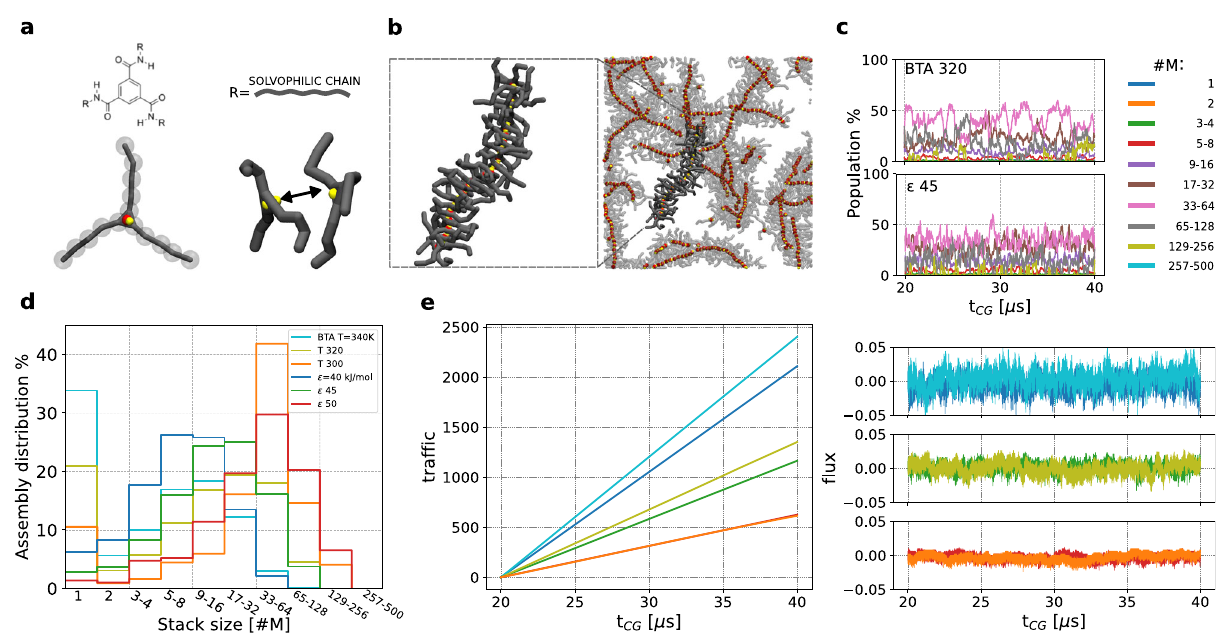
Fig. 4 Coarse-grained model of self-assembling supramolecular polymers. a Molecular structure of a BTA monomer core (top), which can be decorated with generic (e.g., solvophilic) side chains. Bottom: CG model of a BTA -like solvophilic monomer (left), which interacts directionally with monomers of the same specie (right). b Snapshot of BTA fi bres formed spontaneously after t CG = 20 μ s of CG-MD, starting from 500 dispersed BTA monomers. A single fi bre is highlighted and reported in the frame on the left. c Time evolution of the assembly-size populations (in percentage of monomers) for the BTA model at T = 320 K (top) and M model with ϵ = 45 kJ mol − 1 (bottom) at the equilibrium. d Distribution of assemblies of different sizes (percentage over the average number of assemblies) for different BTA and M systems. e Cumulative molecular traf fi c (left) and fl ux (right) 55 vs. time for different BTA and M systems at the equilibrium (same colours of ( d